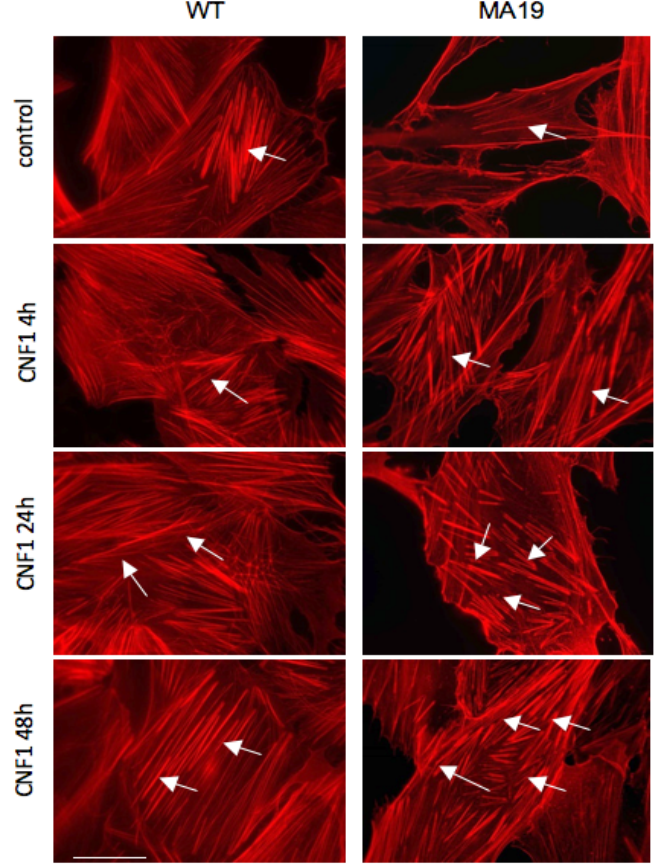
Figure 2. In the MA19 patient’s fibroblasts, CNF1 restores the actin stress fibers’ organization typical of WT cells. Fluorescence micrographs of WT fibroblasts ( left ) column and MA19 fibroblasts ( right ) column treated with CNF1 at the indicated time points. Note that the actin stress fibers’ organization appeared improved in WT fibroblasts with an apparent reinforcement of the actin fibers.